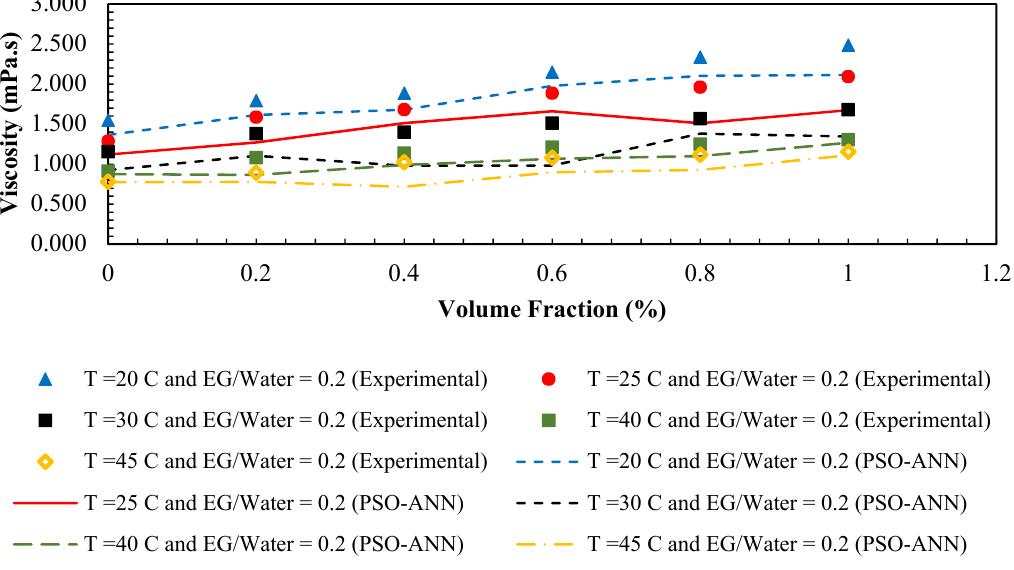
Figure 14. Comparison between PSO-ANN outputs and experimental viscosity of Fe 2 O 3 /ethylene glycol-water nanofluid, versus volume fraction (%) at different condition. Table 4. Calculated statistical indexes of the implemented intelligence-based approaches for the viscosity of Fe 2 O 3 /ethylene glycol-water mixture